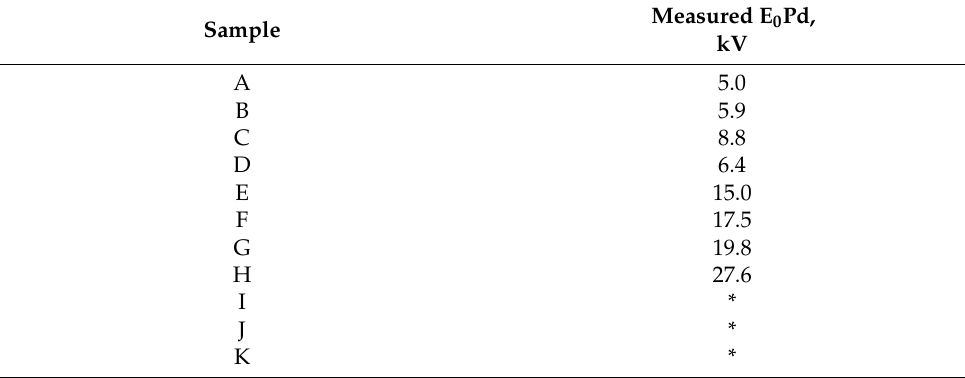
Table 3. Measured E 0 Pd of the unknown Au thickness samples A–H.